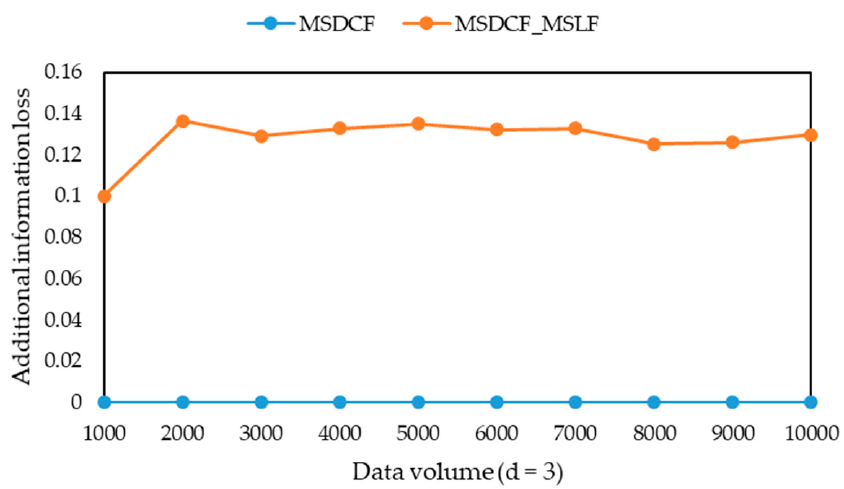
Figure 8. The additional information loss of maximal single-dimension-capacity first (MSDCF) and MSDCF-MSLF with different data volumes ( d = 3).